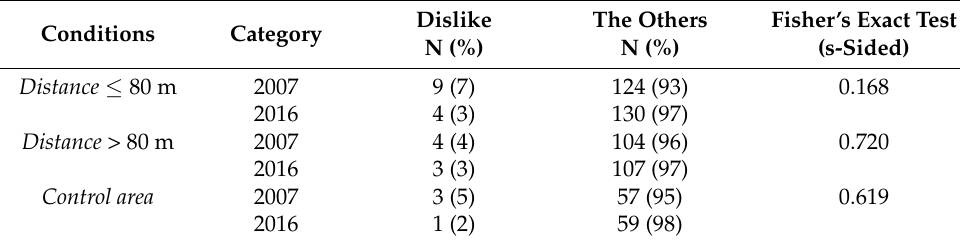
Table 9. Cross-tabulation and Fisher’s exact test for the preference for the residential area. Conditions